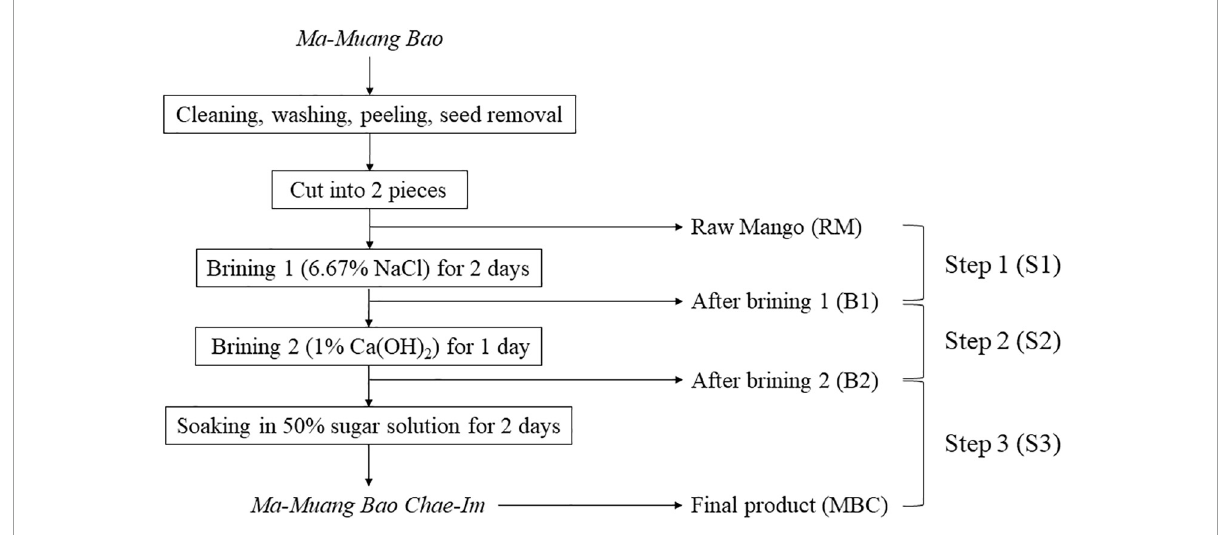
FIGURE1 MBC production process and sample